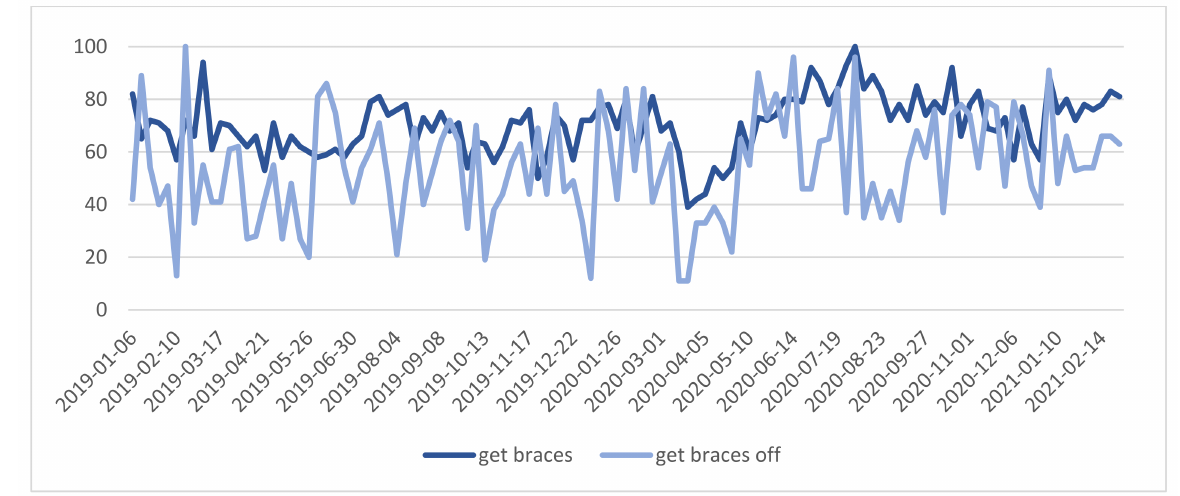
Figure 3. “get braces” and “get braces off” phrases—relative search volume.